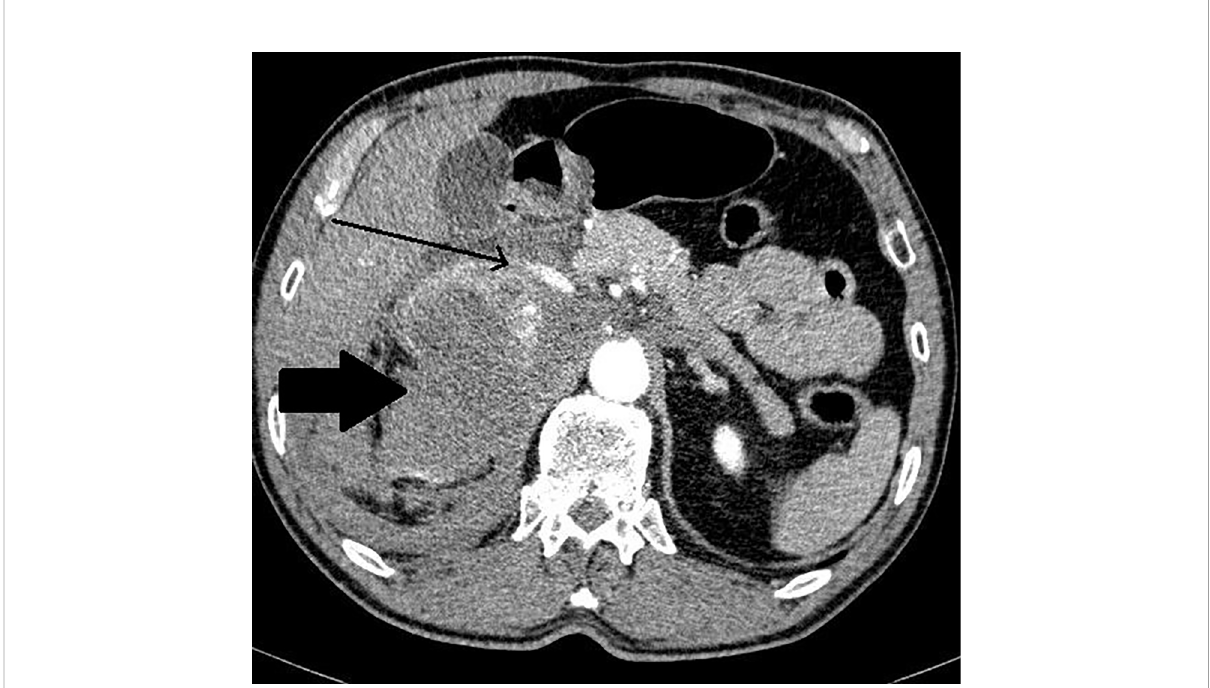
FIGURE 2 Patient number 2: angio-CT, arterial phase, axial image- right adrenal mass with heterogenous enhancement (thick arrow), suspicion of rupture of central part of the tumour with contrast extravasation (thin arrow). Right adrenal gland is not separately visualized. Left adrenal gland visible, with physiological contrast